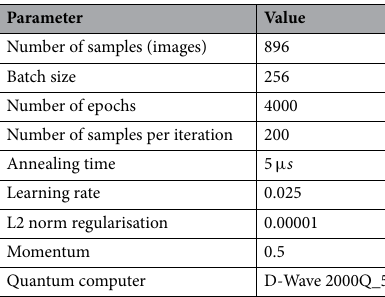
Table 1. Parameters of Boltzmann machine.